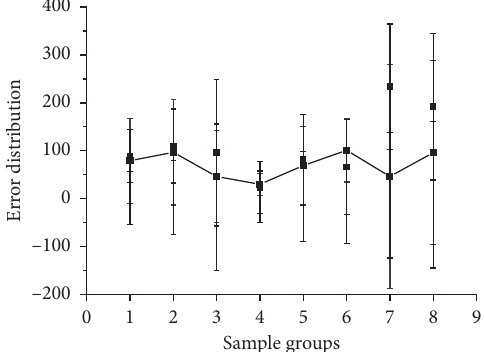
Figure 8: The distribution of public policy and public opinion forecast errors.